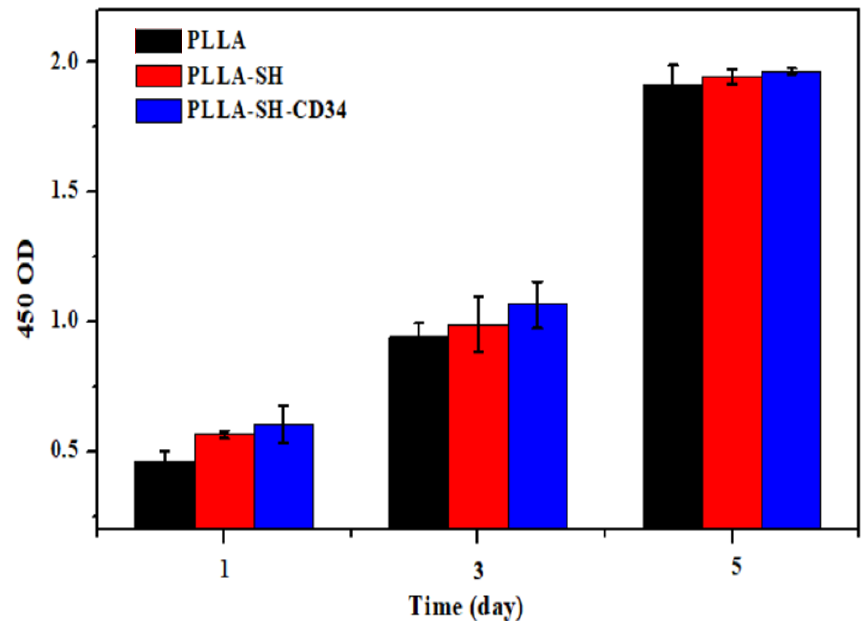
Figure 7. Proliferation of HUVECs on the fiber membranes. CCK-8 assay results for L929 cells on